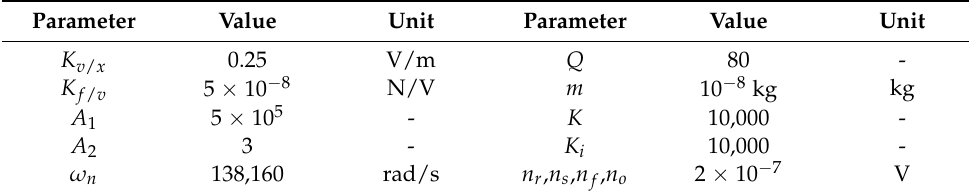
Table 3. Parameters of simulation of x-axis and